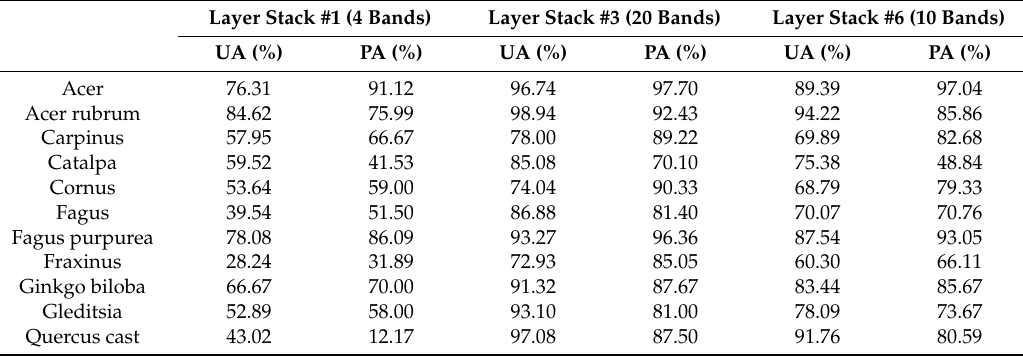
Table 7. Producer’s and User’s Accuracies of layer stacks number 1, 3 and